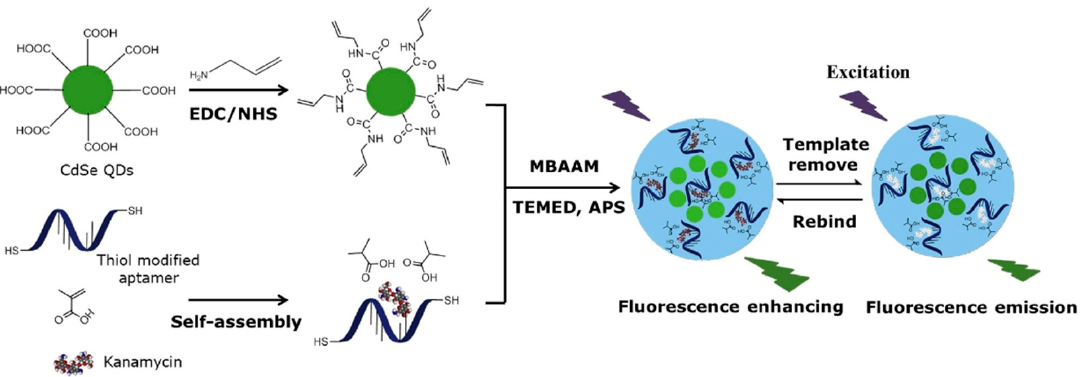
Figure 3. Schematic illustration of the preparation and recognition process for fluorescent aptamer functionalized molecularly imprinted polymers. Reproduced with permission from [42]. Copyright Elsevier, 2018.